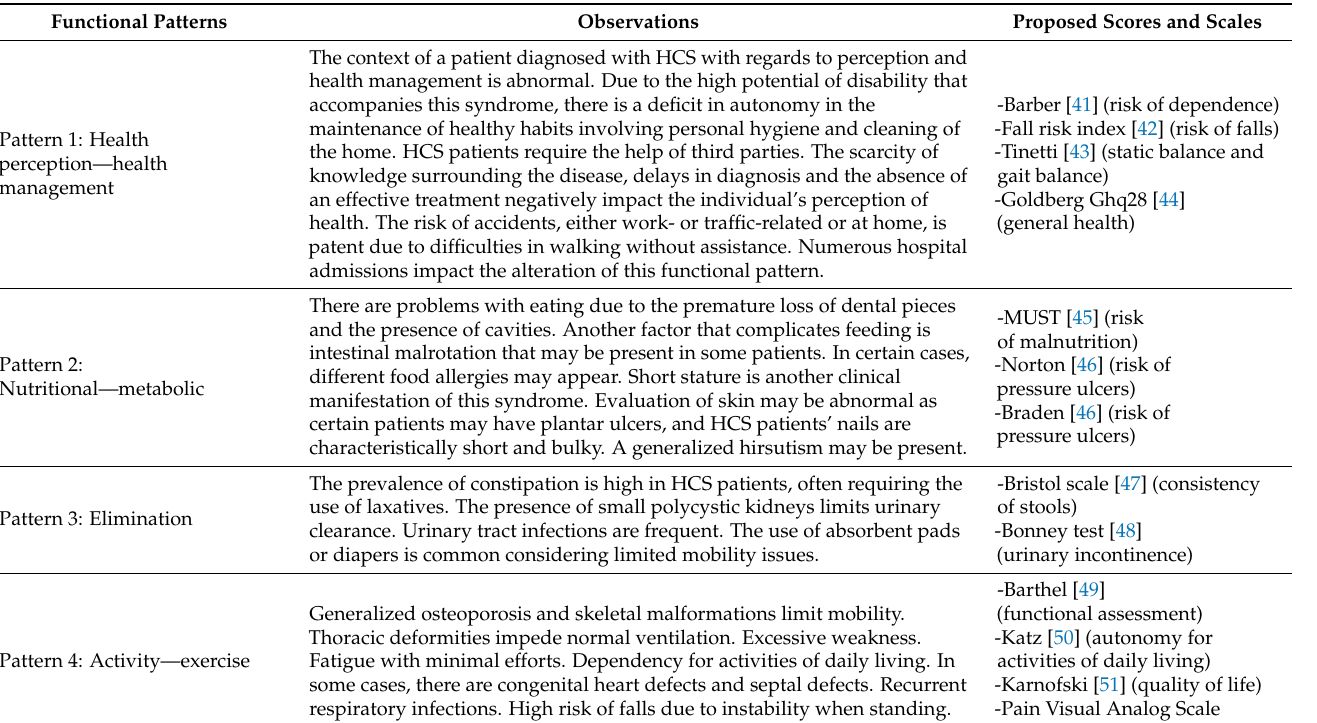
Table 1. Evaluation according to Marjory Gordon functional